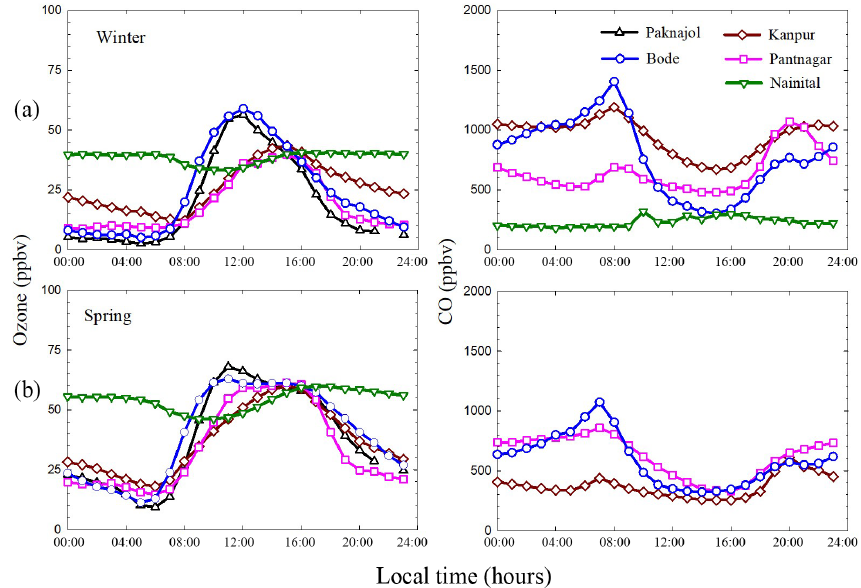
Figure 11. Averaged diurnal variations (winter (a) ; spring (b) ) in ozone and CO at Bode, Pantnagar and Nainital. Surface ozone observations at Kanpur (data from Gaur et al., 2014) and Paknajol (data from Putero et al., 2015) are also shown for the comparison. CO measurements were not available at Nainital during the spring